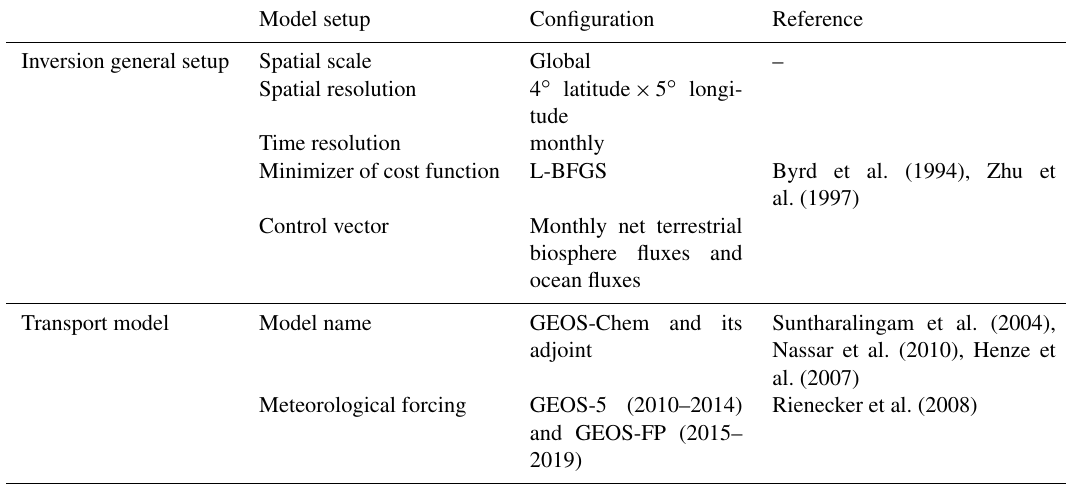
Figure 1. Data flow diagram with the main processing steps to generate regional net biosphere exchange (NBE). TER: total ecosystem respiration; GPP: gross primary production. The green box is the inversion system. The blue boxes are the inputs for the inversion system. The red boxes are the data outputs from the system. The black box is the evaluation step, and the gray boxes are the future additions to the product. Table 1. Configurations of the CMS-Flux atmospheric inversion